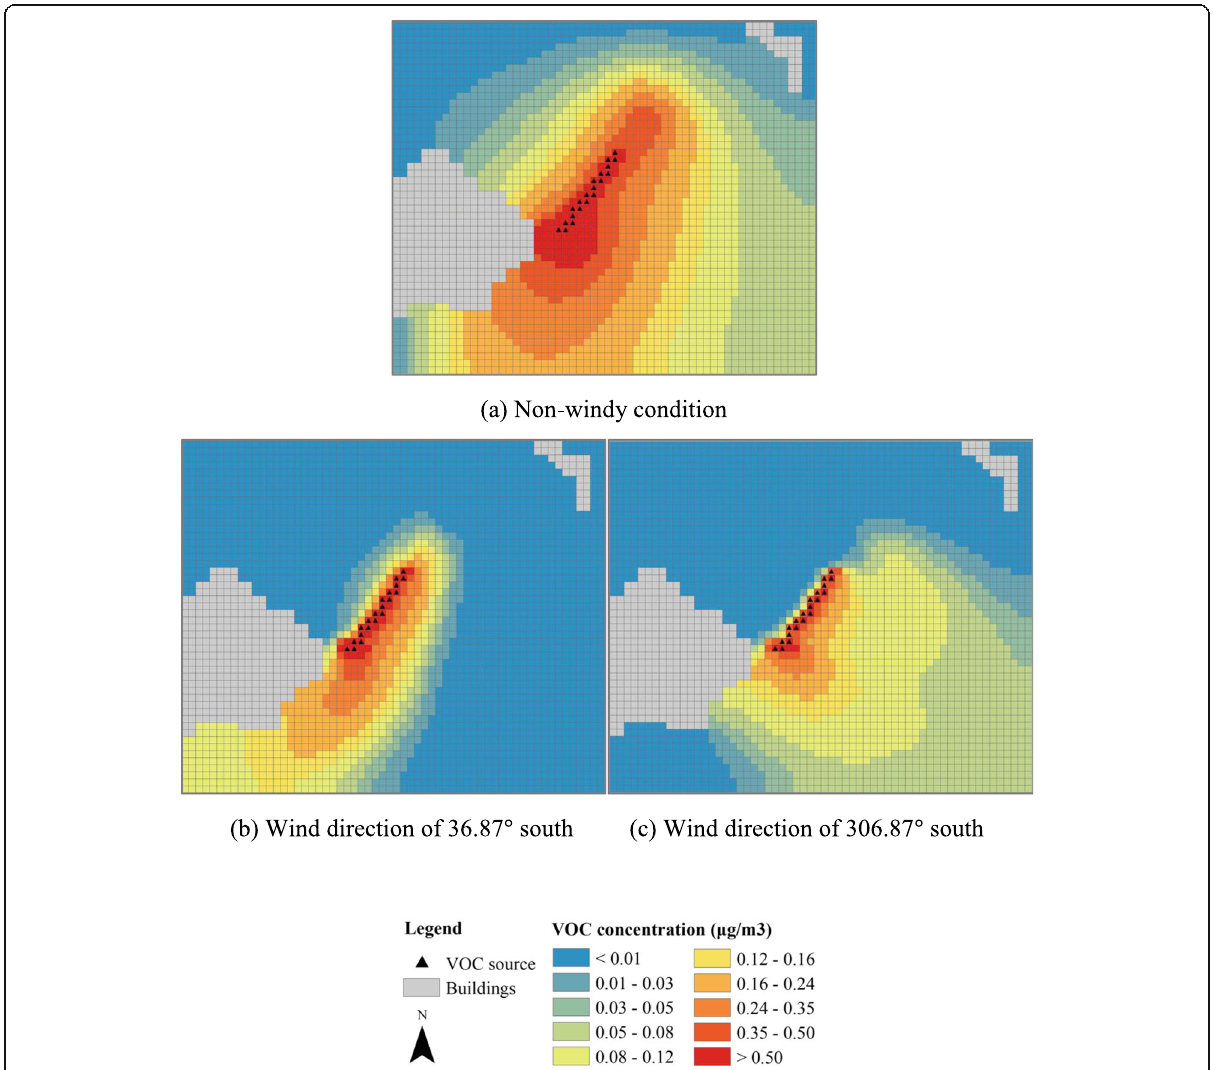
Fig. 11 The VOC concentration of the green corridor with additional flowers planted at the right end of the